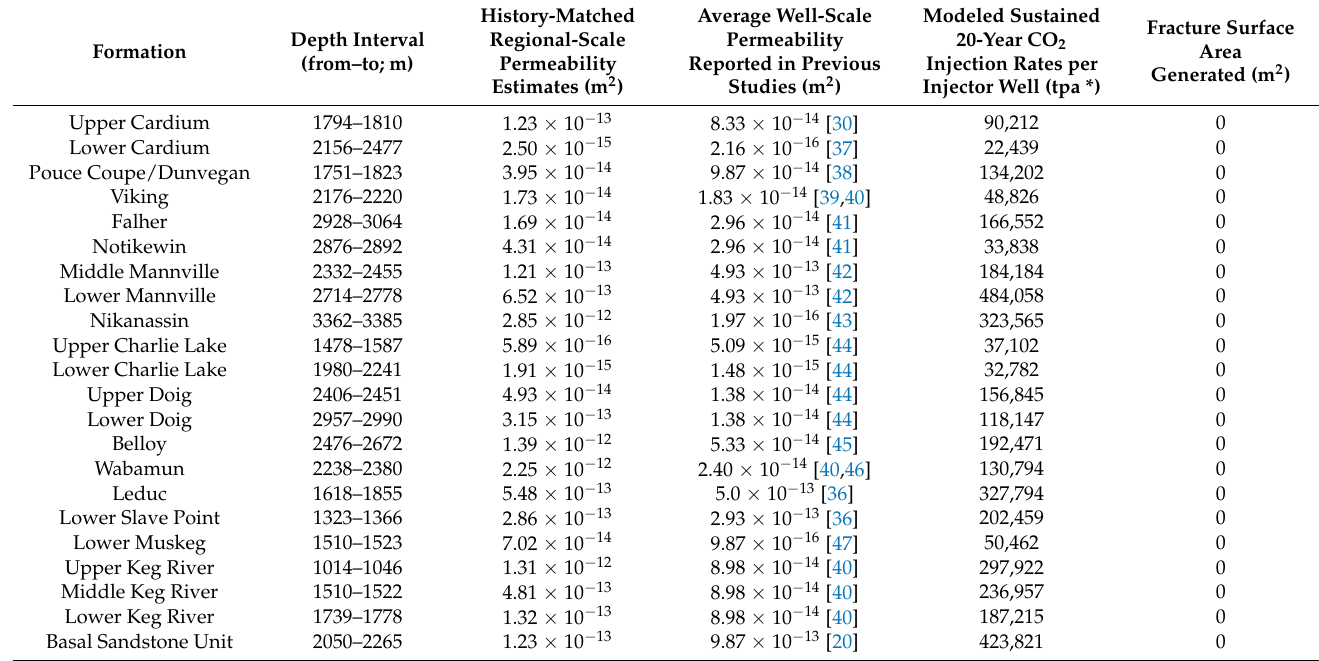
Table 7. Modeled annual CO 2 injection rates for a single injector well operating for 20 years at 90% of σ hmin in each of the formations of interest in the Alberta